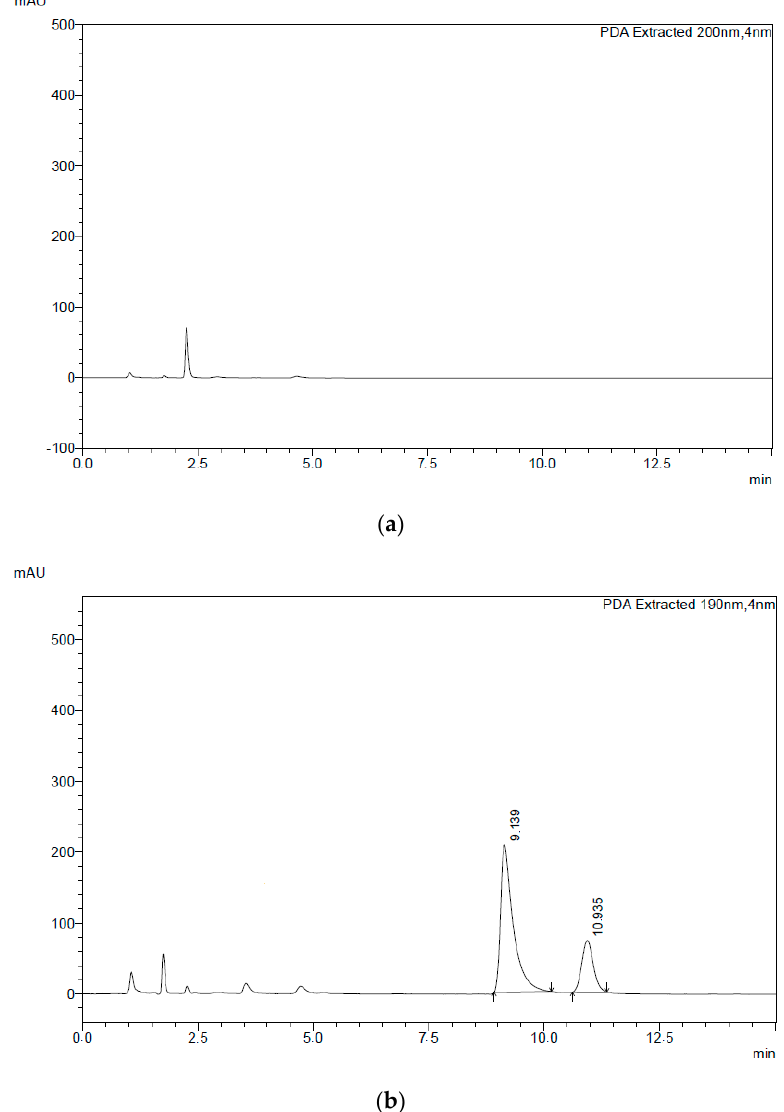
Figure 5. Chromatograms of the ( a ) mobile phase and ( b ) standard solution containing a binary mixture of itraconazole and clotrimazole.